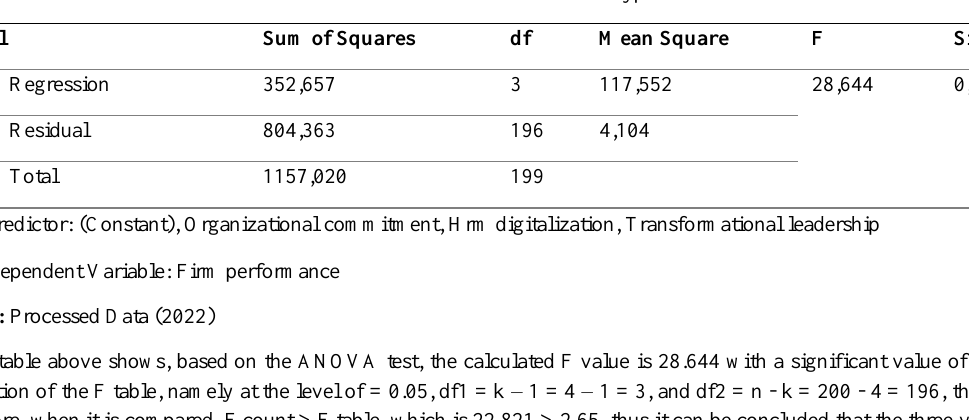
Table 5: Results of Simultaneous Hypothesis Test